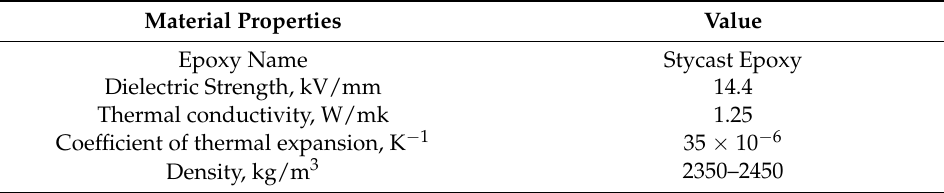
Figure 10. Details of the winding machine. (Insert) Details of the clamped pole. Table 3. Specifications for Stycast Epoxy. Table 3. Specifications for Stycast